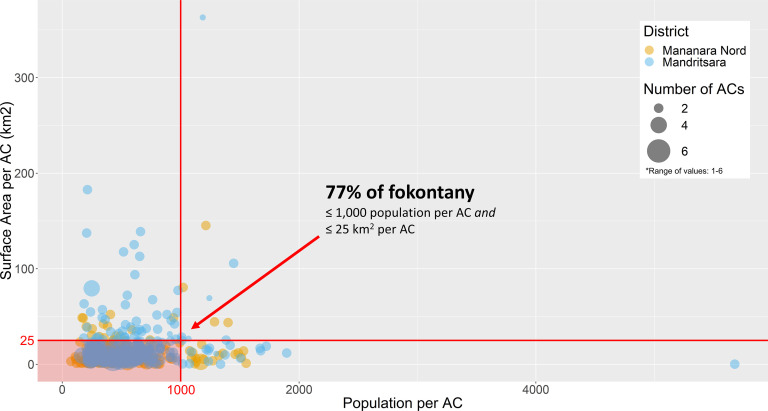
Number of Fokontany per Population and Surface Area Covered by ACsAbbreviation: ACs, agents communautaires (community health workers).